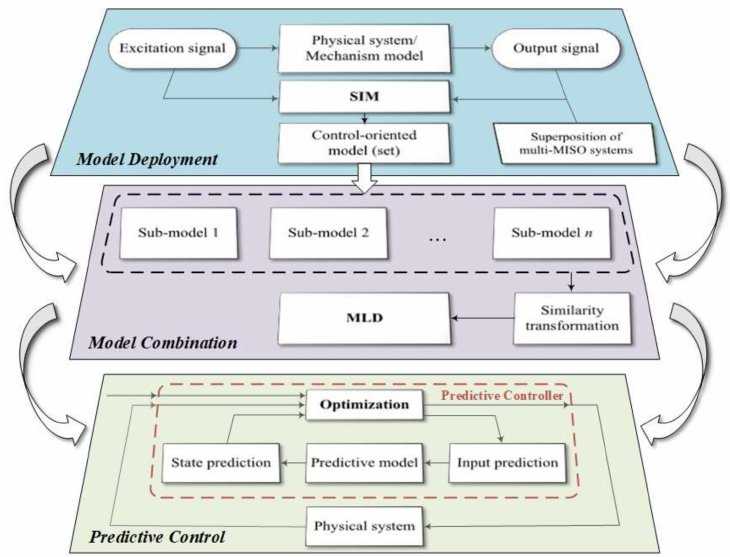
Figure 4. The overall framework of